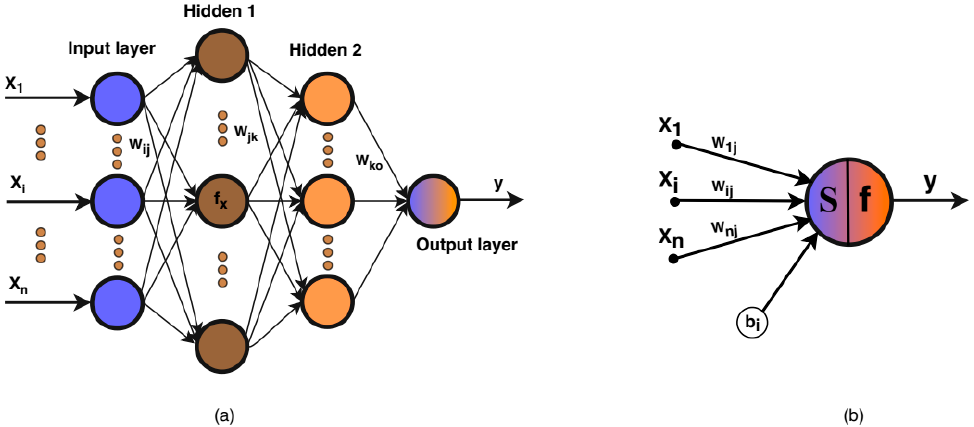
Figure 3. Neural network structure diagram ( a ) and the neuron ( b ).